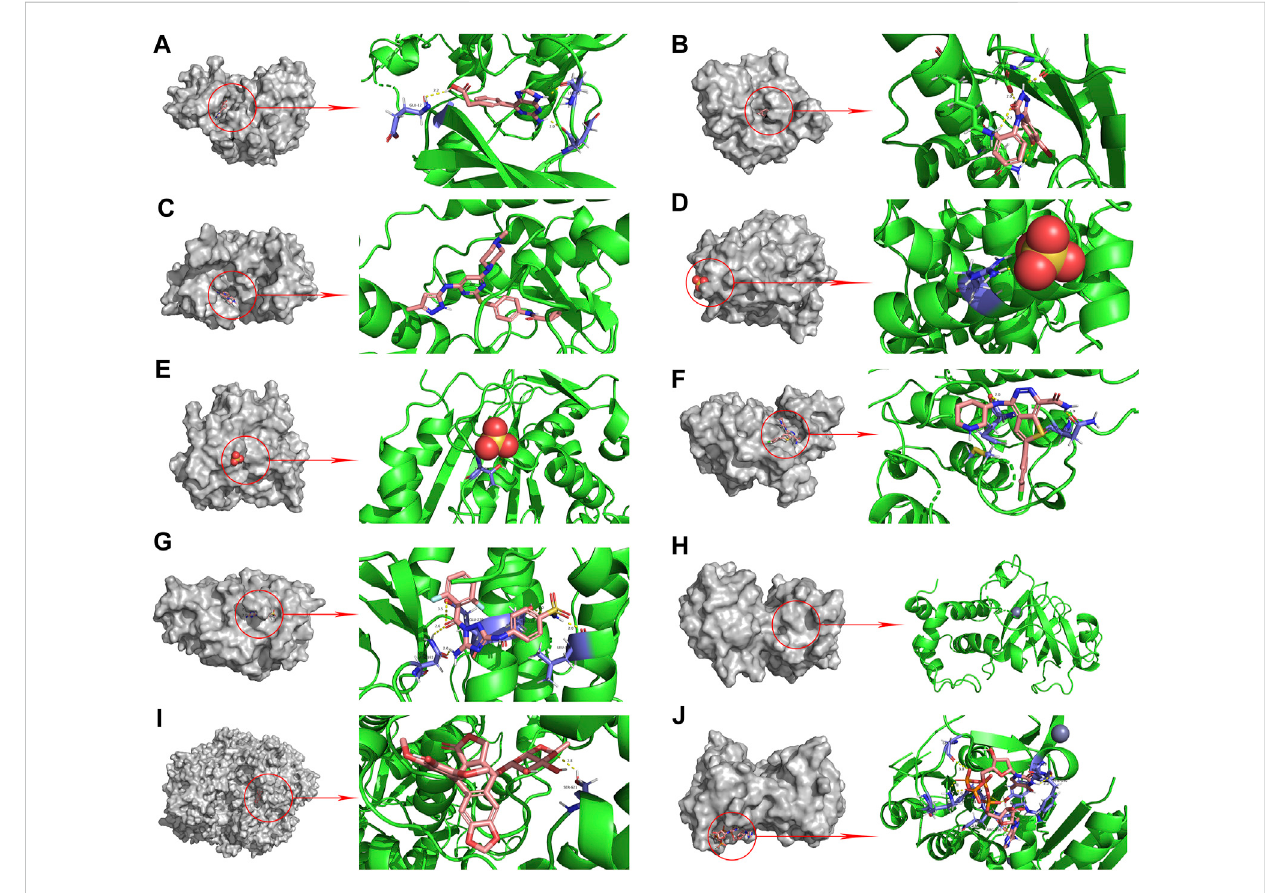
FIGURE 7 Molecular docking pattern of original ligand and core target protein. ( (A) . HJK-CDK2, (B) . 6DL-HSP90AA1, (C) . VX6-AURKB, (D) . SO4-CCNA2, (E) . SO4-TYMS, (F) . C70-CHEK1, (G) . SKE-AURKA, (H) . ZN-DNMT1, (I) . EVP-TOP2A, (J) .